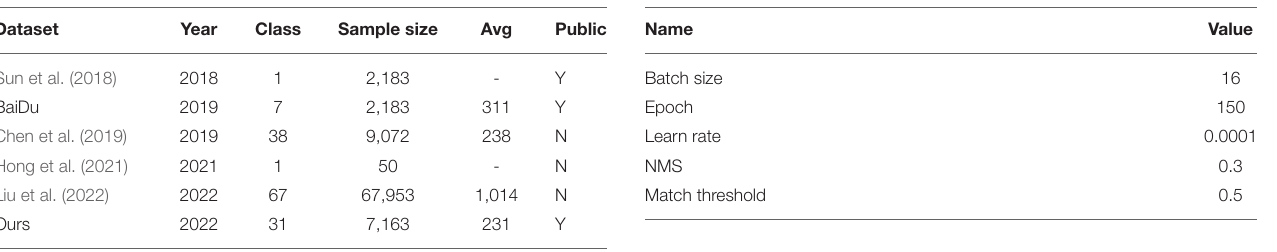
TABLE 4 | Model parameter settings of SSD, Faster RCNN, and YOLOV4.